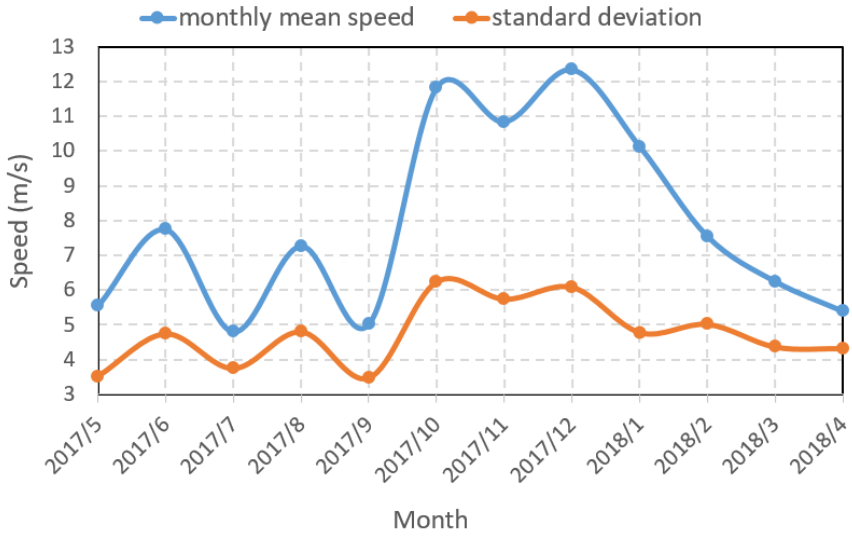
Figure 5. Monthly mean and standard deviation of wind speed at the 90-m height.